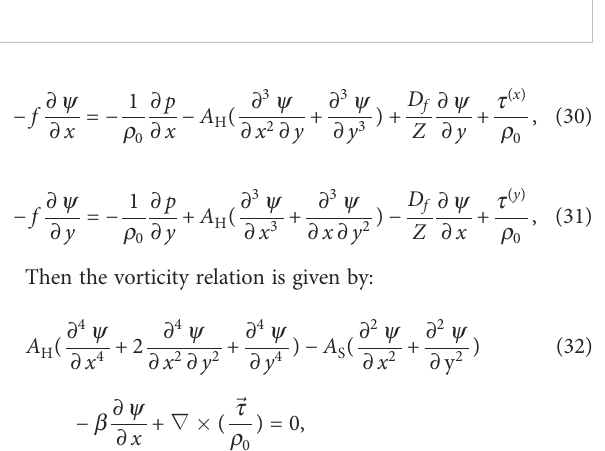
FIGURE 4 As in Figure 2 but for Case 3.